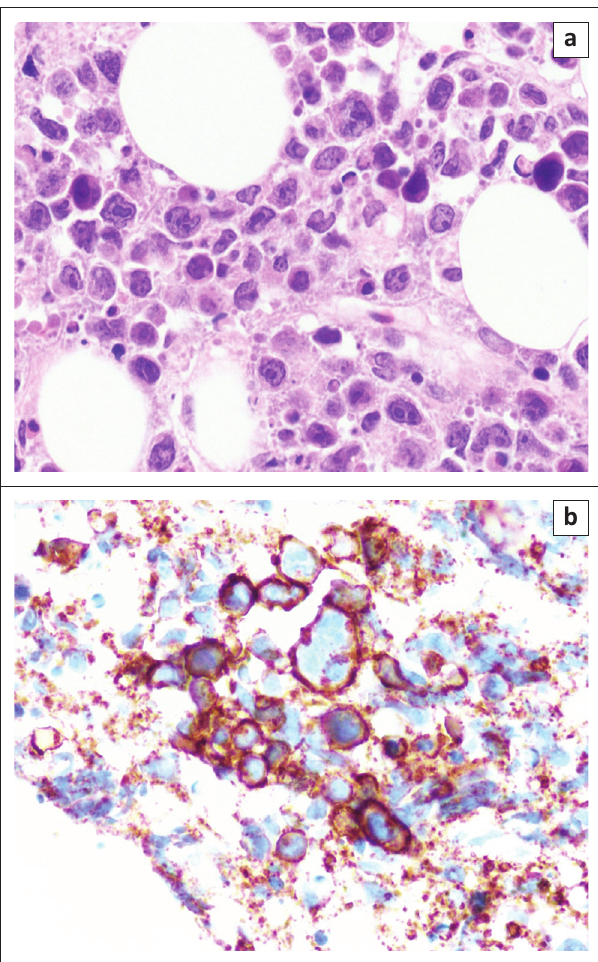
FIGURE 1: Peripheral smear (a) and bone marrow imprint (b) demonstrating scattered large atypical cells with pleomorphic nuclei resembling blasts (May- Grünwald-Giemsa